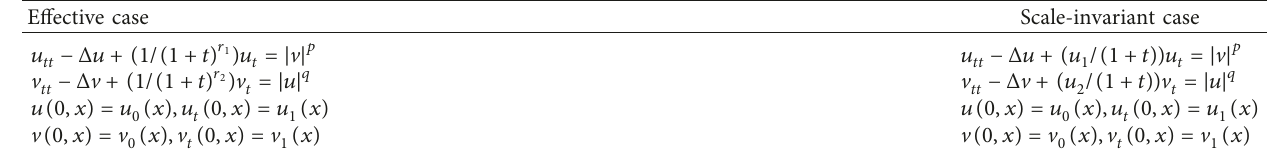
Table 2: Effective case versus scale-invariant